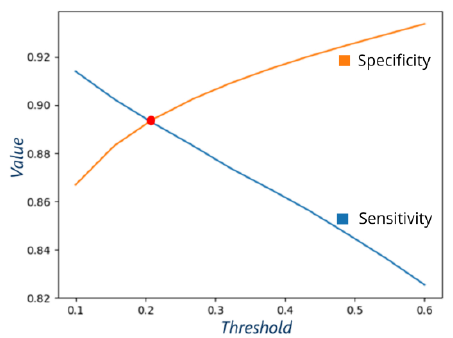
Figure 4. Sensitivity and specificity obtained for one of the implemented models. The red point is the intersection point of both curves and represents the optimal threshold value used to define the binary probability map.